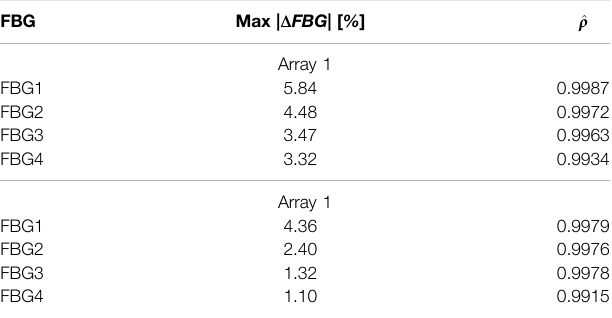
TABLE 3 | Maximum absolute error and correlation coef fi cients for the simulated and measured temperatures for the fi rst 4 FBGs of Array 1 and 2. FBG